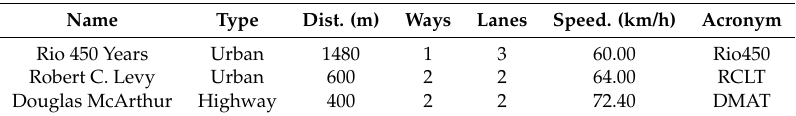
Table 3. Tunnel technical